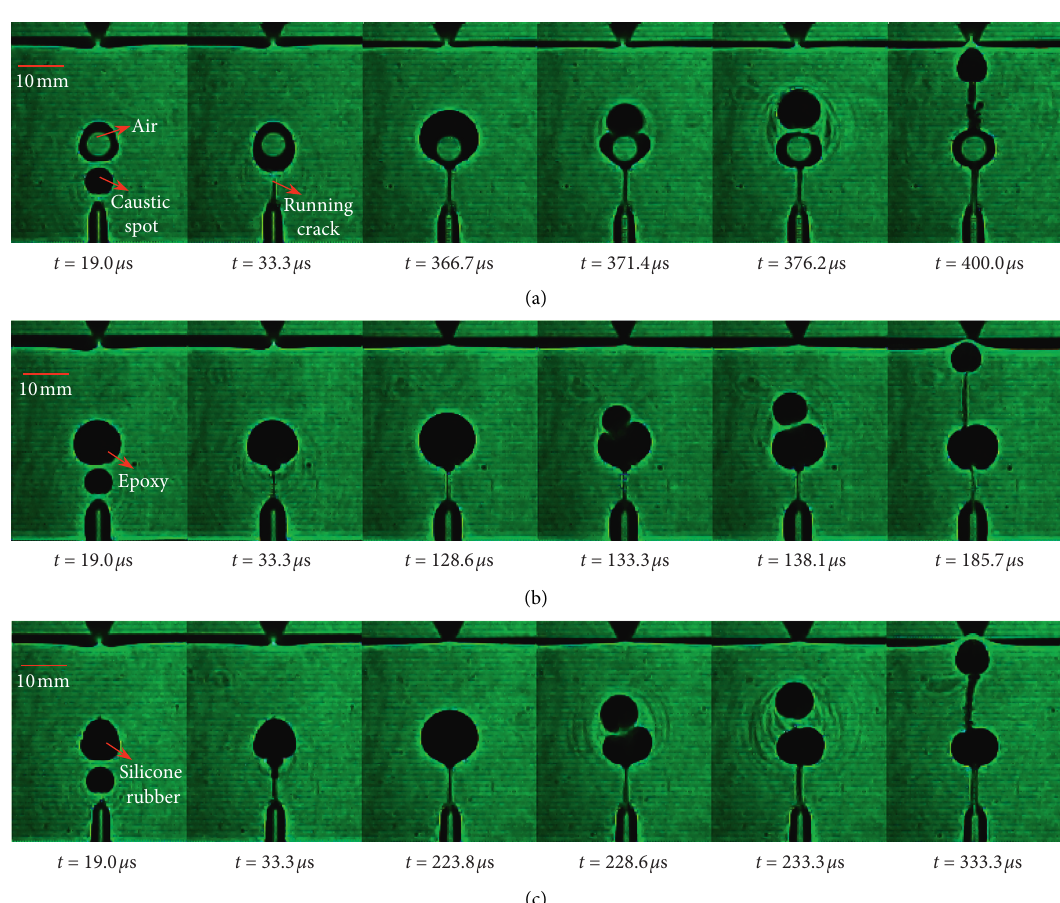
Figure 5: Caustics photos of the interaction between the running crack and circular defect. (a) Specimen C C s